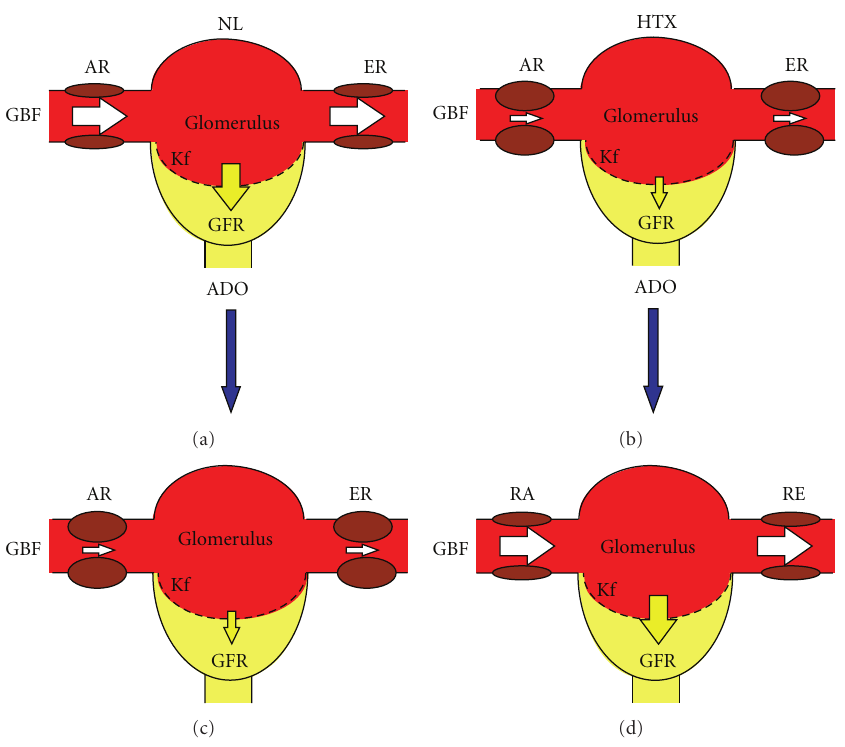
Figure 3: E ff ect of adenosine (ADO) on glomerular hemodynamics in normal and (NL) and hypothyroid (HTX) rats. (a) The balance of glomerular blood flow (GBF), the a ff erent and e ff erent resistances (AR, ER, resp.), and the permeability of the glomerular capillary membrane (Kf) maintain a normal glomerular filtration rate (GFR). (c) Administration of exogenous adenosine to normal rats produces an increase in a ff erent and e ff erent resistances, which in turn result in decreased glomerular blood flow and glomerular permeability; as a final consequence, the glomerular filtration rate diminishes. (b) Glomerular hemodynamics of the hypothyroid kidney. There is a glomerular vasoconstriction due to an increase in a ff erent and e ff erent resistances, a decrease in glomerular blood flow, and permeability of the glomerular capillary membrane, which results in a decreased glomerular filtration rate. (d) When exogenous adenosine is administrated to HTX rats, glomerular hemodynamics and GFR reach values near to normal. White arrows are indicative of magnitude of AR or ER, whereas yellow arrows represent the magnitude of the glomerular filtration